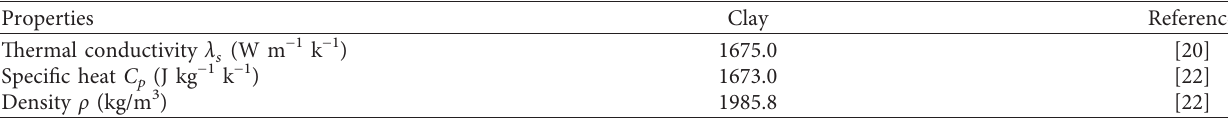
Table 3: Thermal properties of the clay brick.